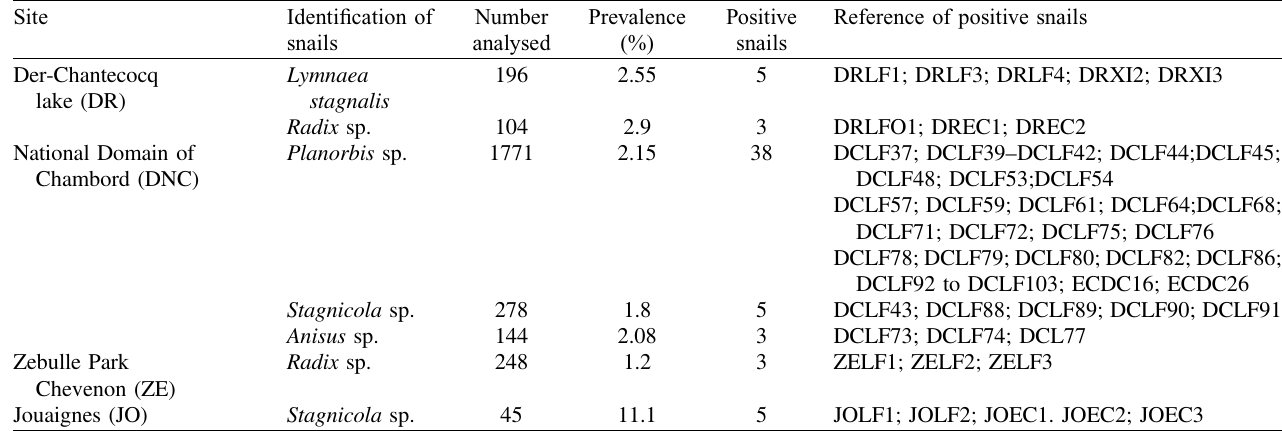
Table 1. Geographic origin of